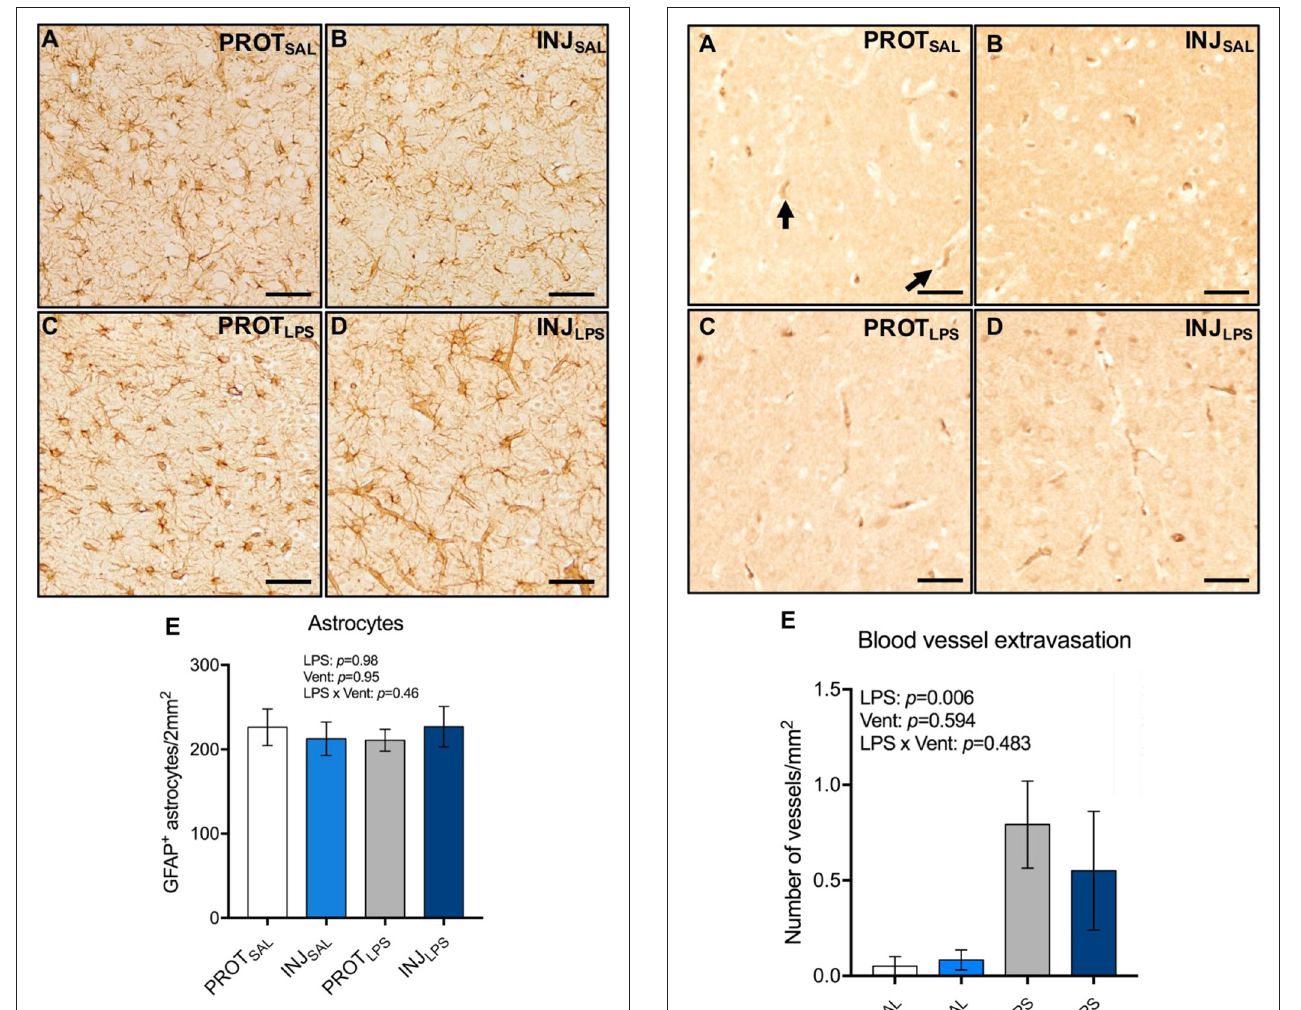
FIGURE 6 | Ventilation strategy and LPS exposure does not alter astrocyte numbers in the cortical gray matter . Representative images of GFAP + astrocytes in the gray matter (A–D) . Neither ventilation strategy, or LPS exposure caused changes in the number of astrocytes (E) . Magnification = 2x, scale bar = 20 µ m. PROT SAL , N = 5; PROT LPS , N = 6; INJ SAL , N = 6; and INJ LPS , N = 5.